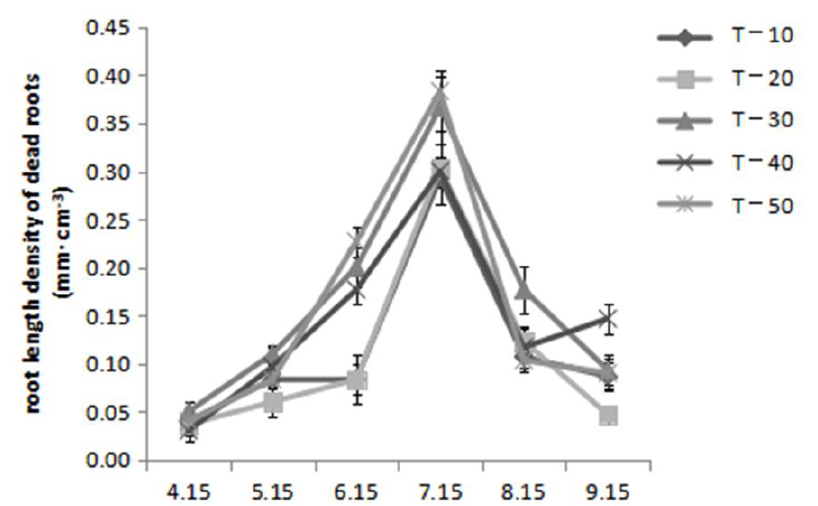
Figure 2. Effect of dwarfing interstock length on root length density of dead roots.